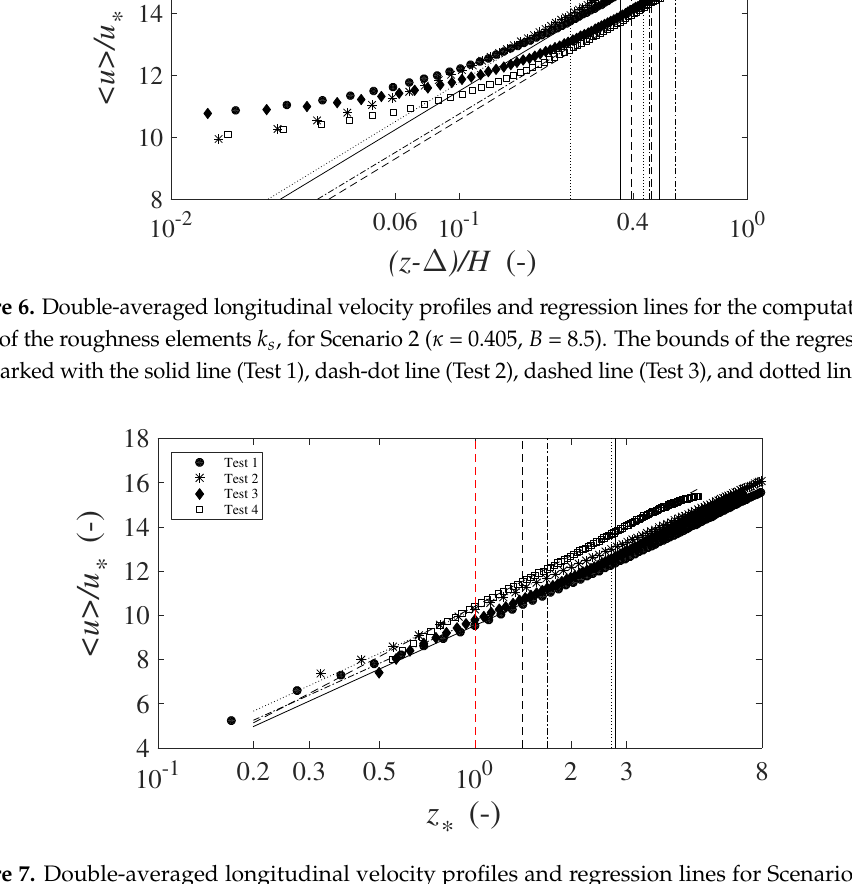
Figure 7. Double-averaged longitudinal velocity profiles and regression lines for Scenario 3, where z ∗ = ( z − ∆ ) / ( k s − ∆ ) . Vertical line specifications are as in Figure 5.The bounds of the regression lines are marked with solid line (Test 1), dash-dot line (Test 2), dashed line (Test 3), and dotted line (Test